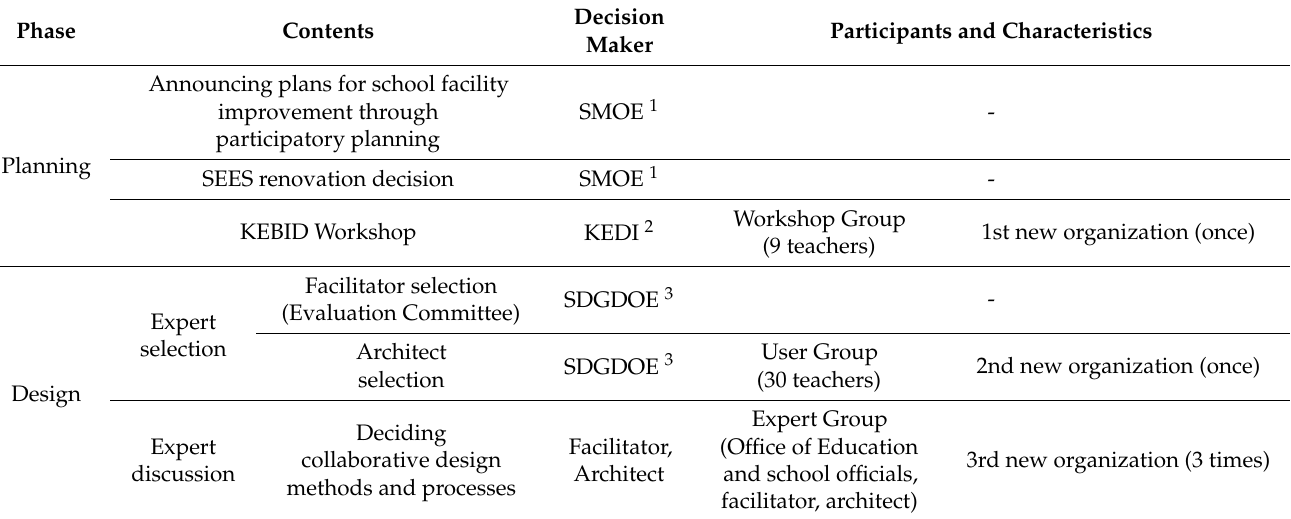
Table 3. User participation in the planning and expert selection process of the SEES project (chrono- logical